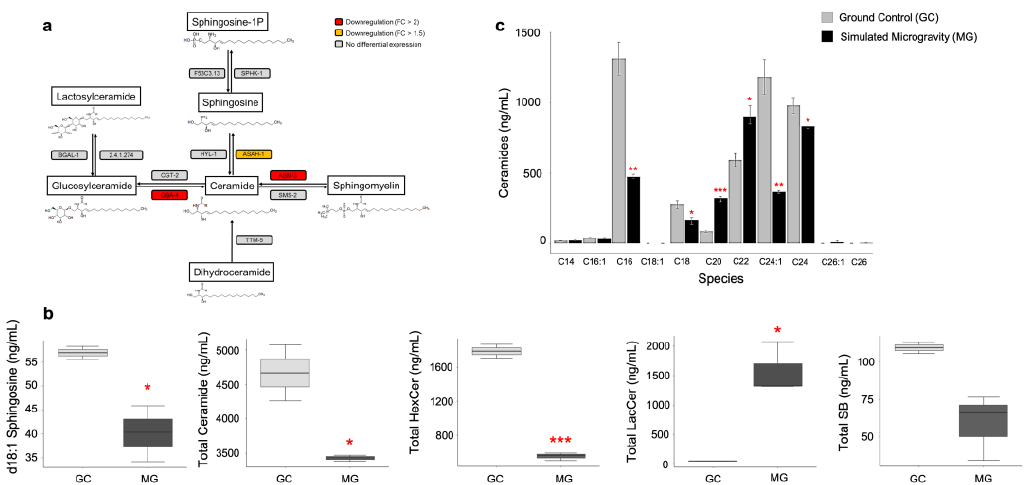
Figure 4. Sphingolipid signaling pathway is downregulated under simulated microgravity. ( a ) The sphingolipid signaling pathway genes asah-1 , asm-3 , and gba-4 are downregulated under simulated microgravity. The downregulation pattern of asm-3 and gba-4 is maintained for eight days after return to ground conditions. ( b ) The levels of d18:1 sphingosine, total ceramide, hexosylceramide, and sphingoid base reduced while total lactosylceramide level increased under simulated microgravity. ( c ) The levels of different acyl-chain ceramides show alterations under simulated microgravity. The error bars represent the standard error of the mean (* p < 0.05, ** p < 0.01, *** p < 0.001) .